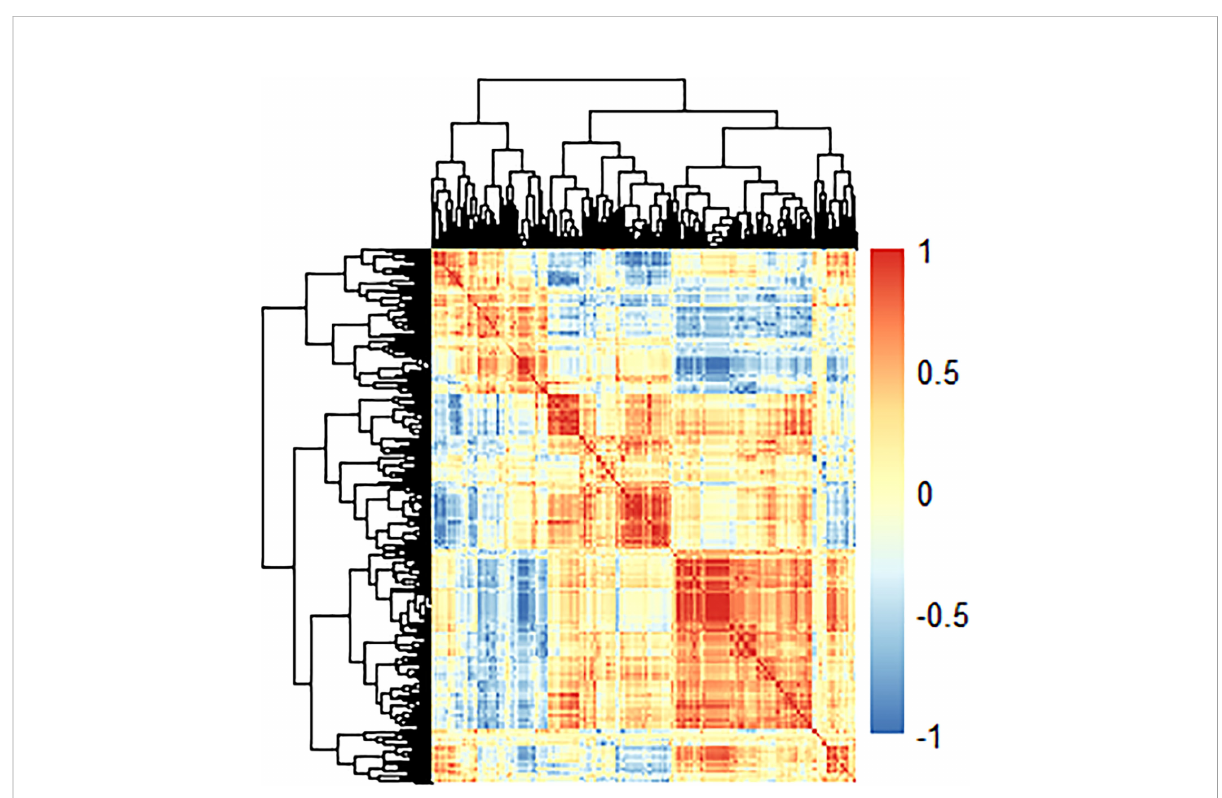
FIGURE 3 The heat-map displays the correlation between radiomics features in the training